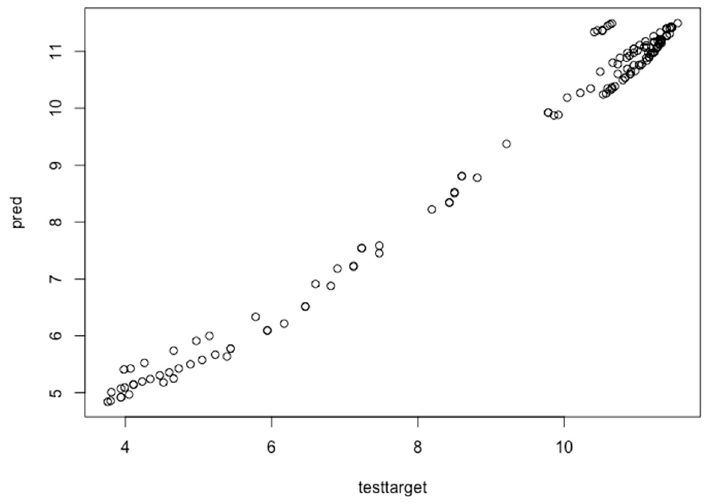
Figure 14. Performance evaluation test for hourly wind power prediction after fine-tuning